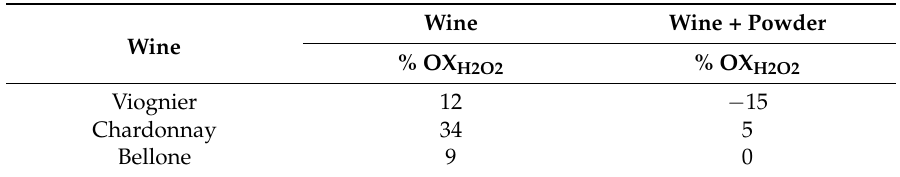
Table 4. POM-test performed without and with the addition of powder (2 g/L). Percent increase (% OX H2O2 ) of the absorbance at 420